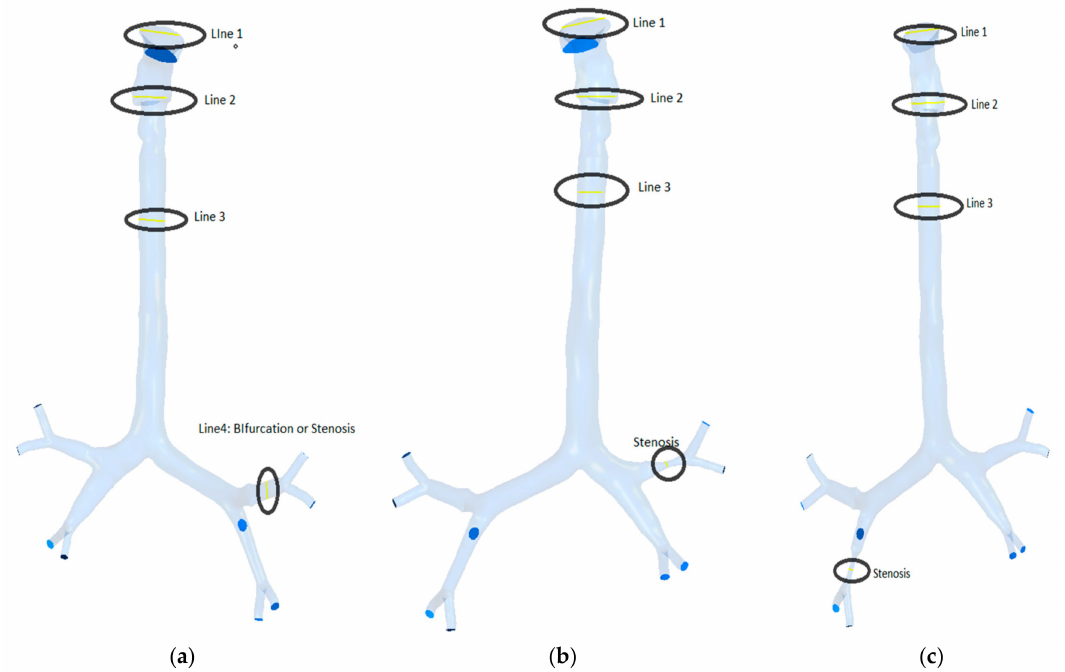
Figure 4. Selected lines for velocity profile: ( a ) healthy model, ( b ) right stenosis, and ( c ) left stenosis.